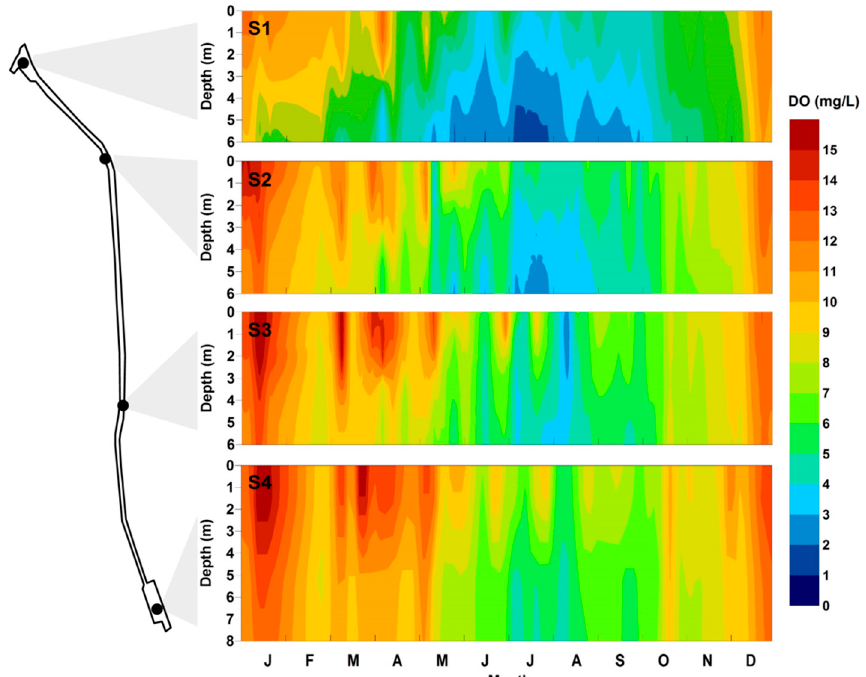
Figure 4. Temporal and vertical distributions of DO concentration measured at sites S1 − S4.